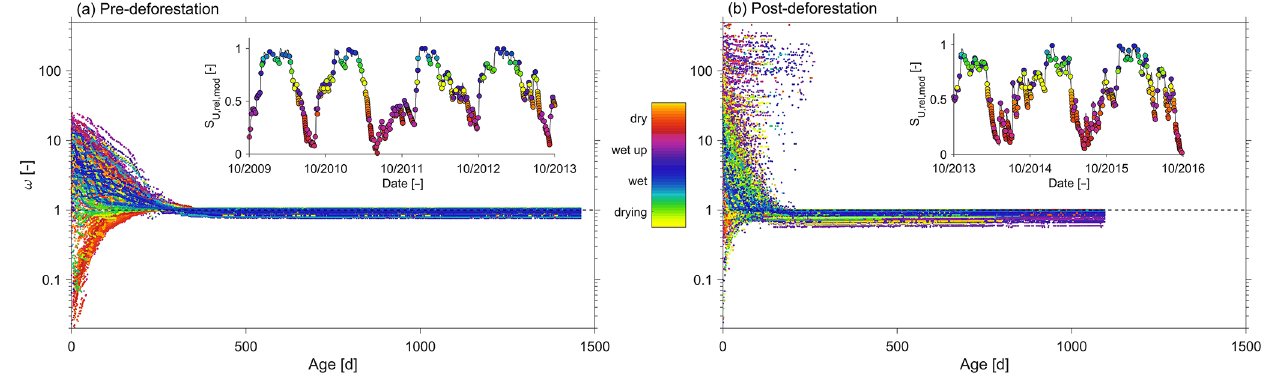
Figure 11. Individual catchment overall SAS ω functions for individual time steps under different wetness conditions in the (a) pre- deforestation period and (b) post-deforestation period. The insets show the relative water content in S U,rel,mod = S U /S U,max at the individual time